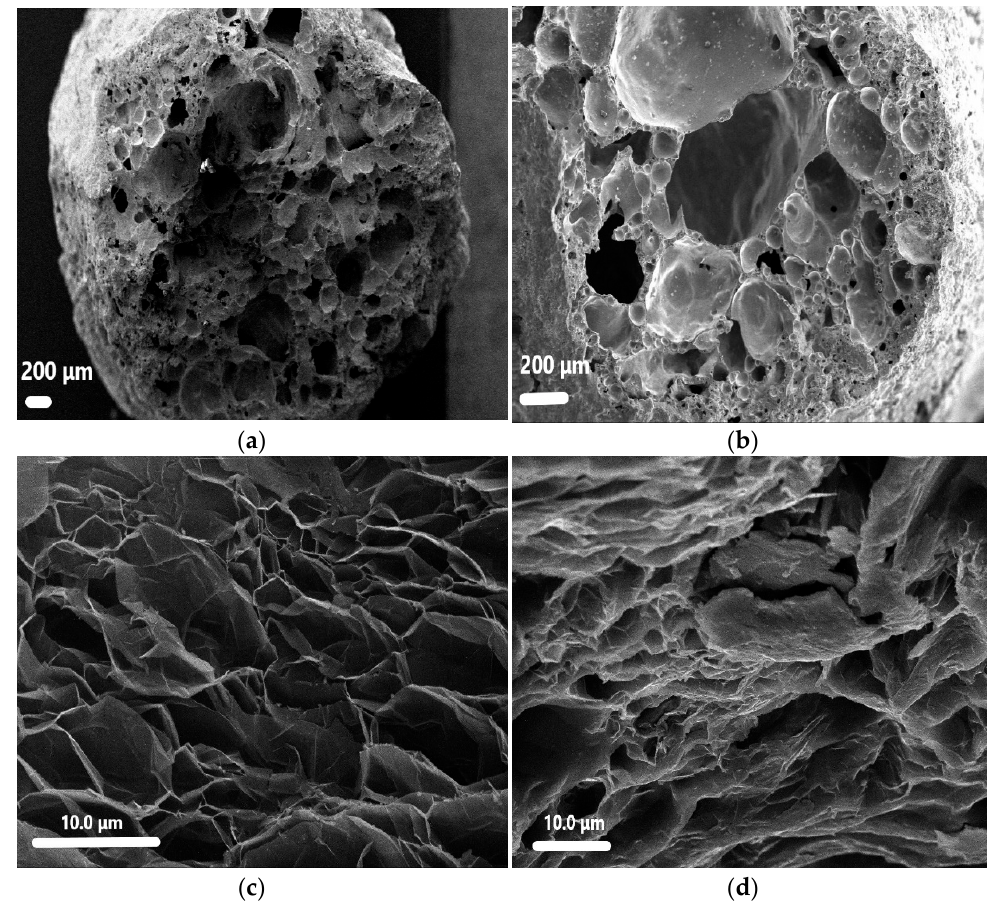
Figure 4. SEM images of samples: ( a ) CS; ( b ) paraffin/CS; ( c ) expanded graphite (EG); ( d ) paraffin/EG.